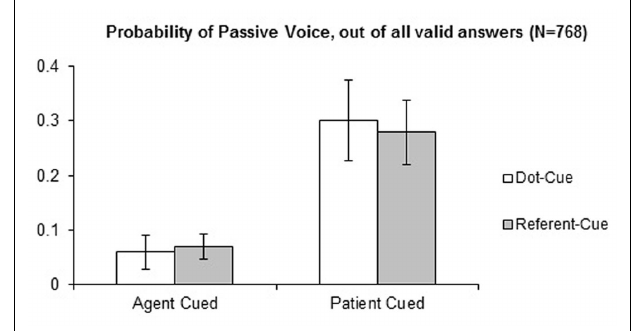
FIGURE 4 | Mean passive-voice probabilities per condition (with by-subject